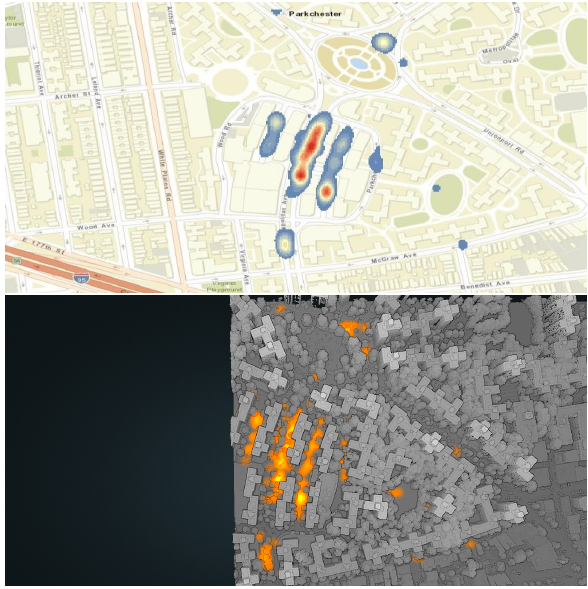
Figure 3. Cumulative egress behavioral data visualized as heatmaps in ArcGIS (top) and in Potree (bottom).